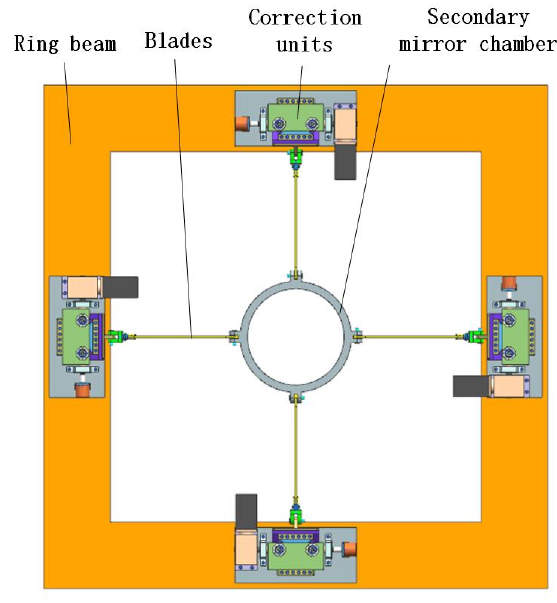
Figure 4. The overall structure of the SMAM.